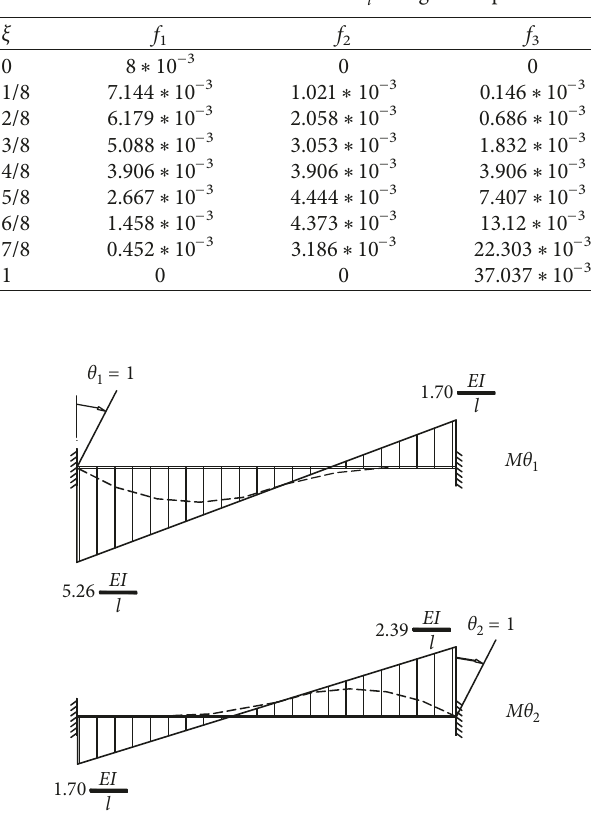
Figure 2: Bending moment diagrams due to unit rotation at ends.